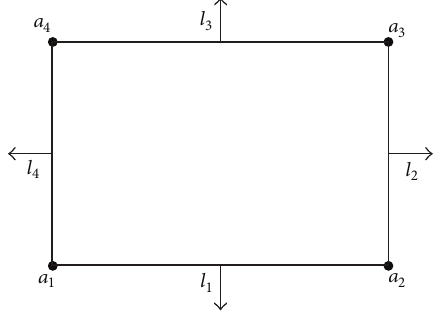
Figure 1: The degrees-of-freedom of incomplete biquadratic ele-